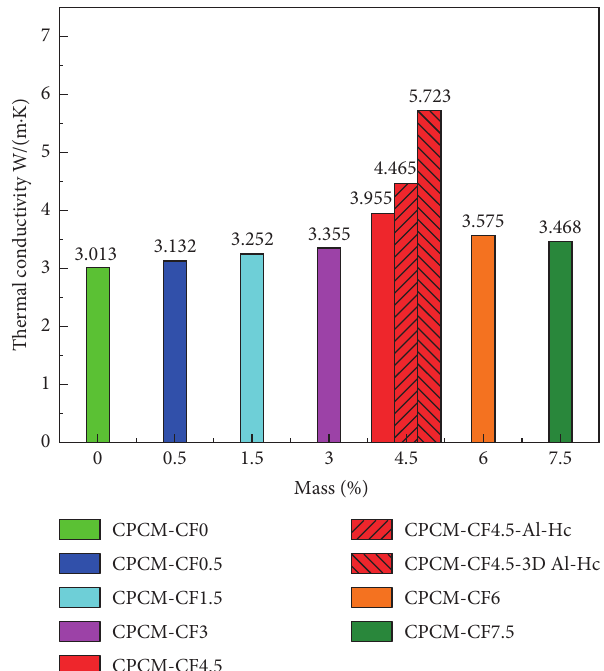
Figure 10: Thermal conductivity of the CPCM with different CF mass fractions.